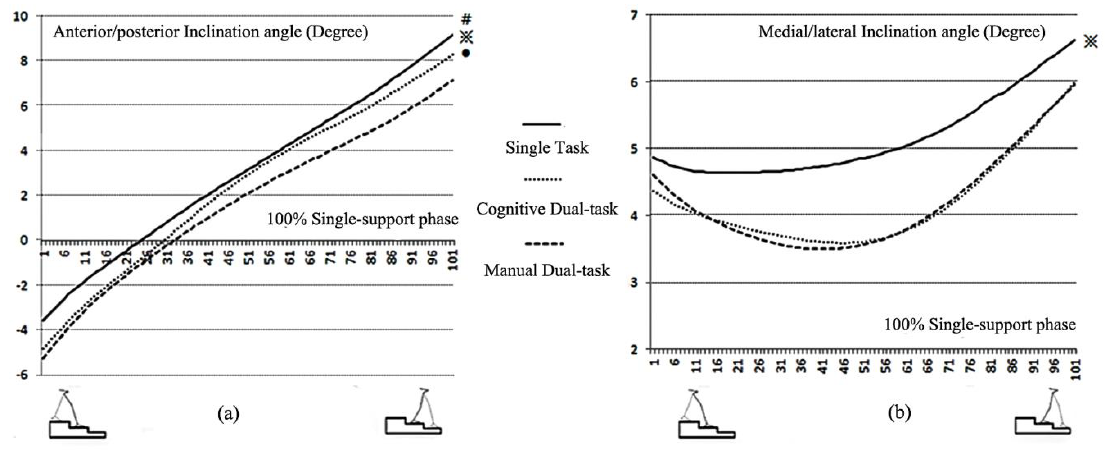
Figure 3. COM–COP inclination angles (y) of the single-support phase (x) in the ( a ) anterior / posterior Figure 3. COM – COP inclination angles (y) of the single-support phase (x) in the (a) anterior/posterior and ( b ) medial / lateral directions; # Significant di ff erence between single-task and cognitive dual-task and (b) medial/lateral directions; ＃ Significant difference between single-task and cognitive dual- conditions; ※ Significant di ff erence between single-task and manual dual-task conditions; • Significant task conditions; ※ Significant difference between single-task and manual dual-task conditions; ● di ff erence between cognitive dual-task and manual dual-task Significant difference between cognitive dual-task and manual dual-task conditions.